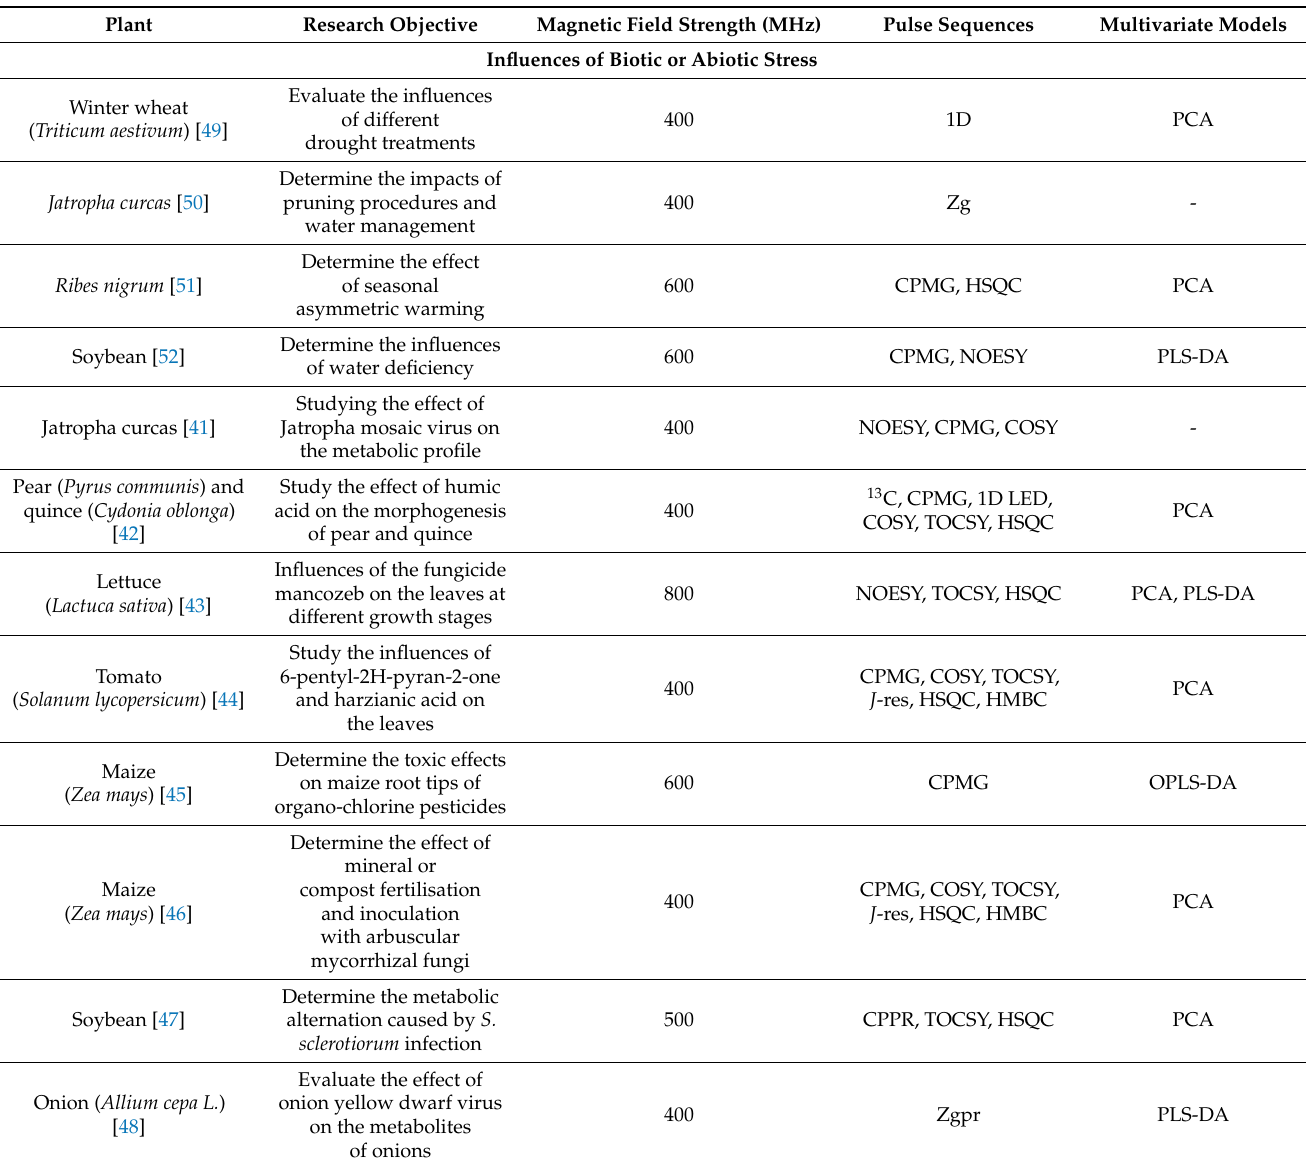
Table 3. Summary of the publications studying metabolomics using high-resolution magic angle spinning NMR. COSY, Correlation Spectroscopy; CPMG, Carr-Purcell-Meiboom-Gill; CPPR, composite pulses presaturation; HCA, hierarchical cluster analysis; HMBC, heteronuclear multiple bond correlation; HMQC, heteronuclear multiple-quantum correlation; HSQC, heteronuclear single quantum coherence; J-res, J-resolved, KNN, k-nearest neighbors; NOESY, nuclear Overhauser effect spectroscopy, OPLS-DA, orthogonal partial least squares discriminant analysis; PCA, principal component analysis; PLS-DA, partial least-squares discriminant analysis; STOCSY, statistical total correlation spectroscopy; TOCSY, total correlated